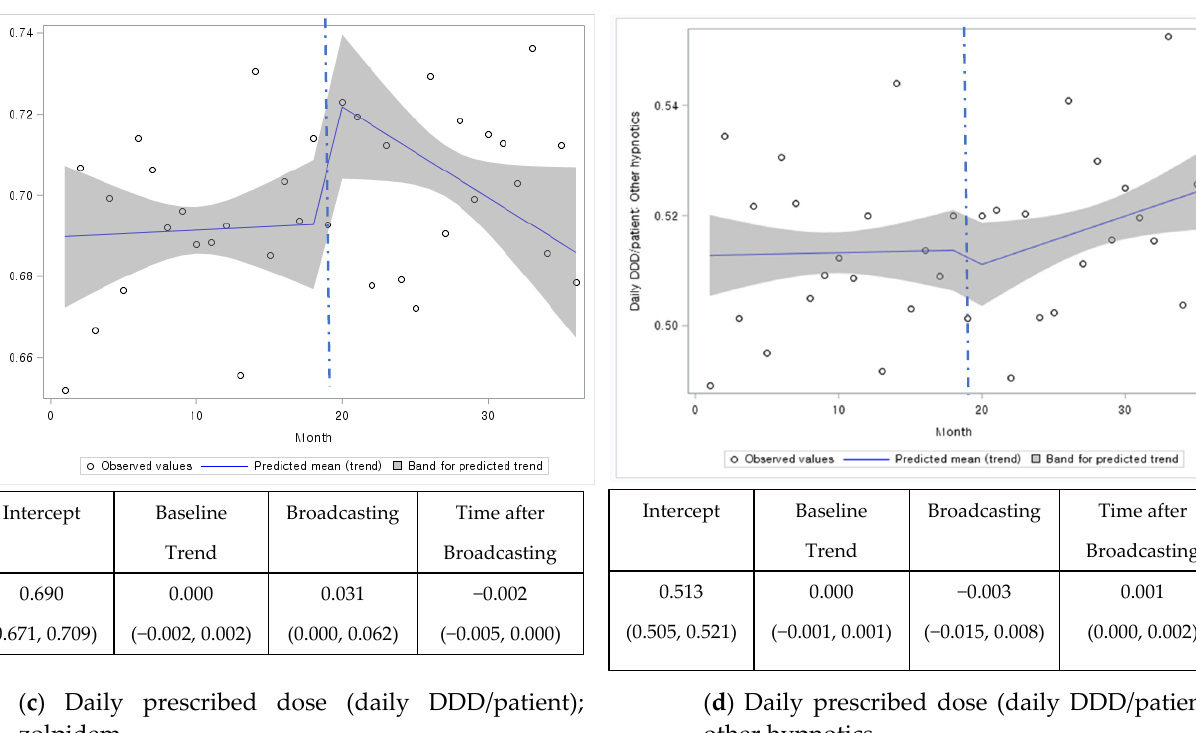
Figure 1. Overall monthly prescription rate or average daily prescribed dose of zolpidem or other hypnotics, 2015–2017. DDD; Defined daily dose.